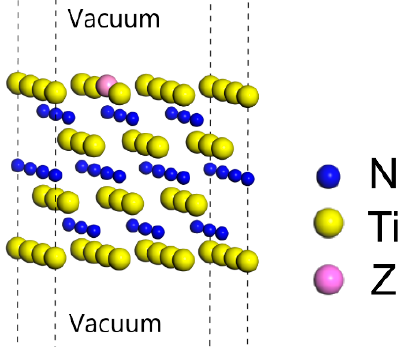
Figure 7. Schematic of doping transition metal Z ( Z = Sc, V, Zr) on the Ti 4 N 3 nanosheet.